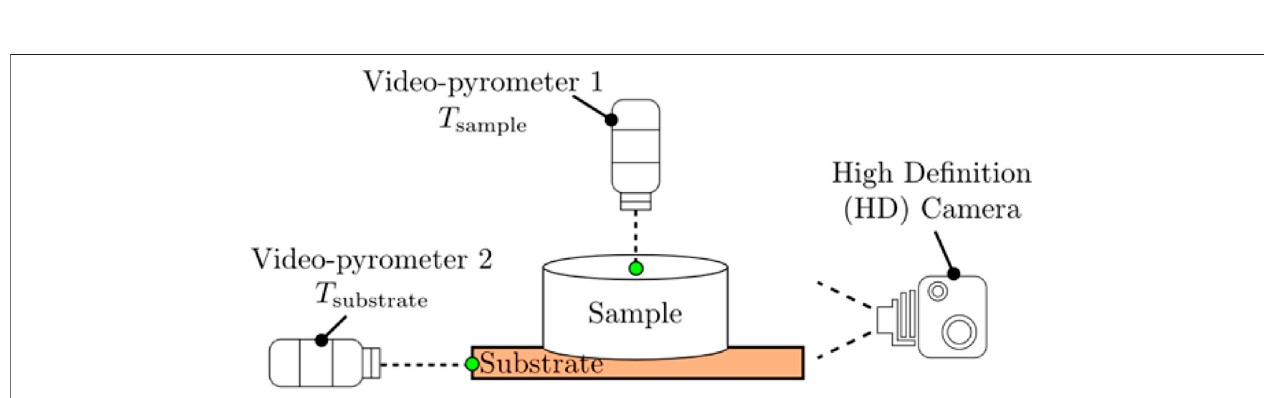
Frontiers in Energy Research |